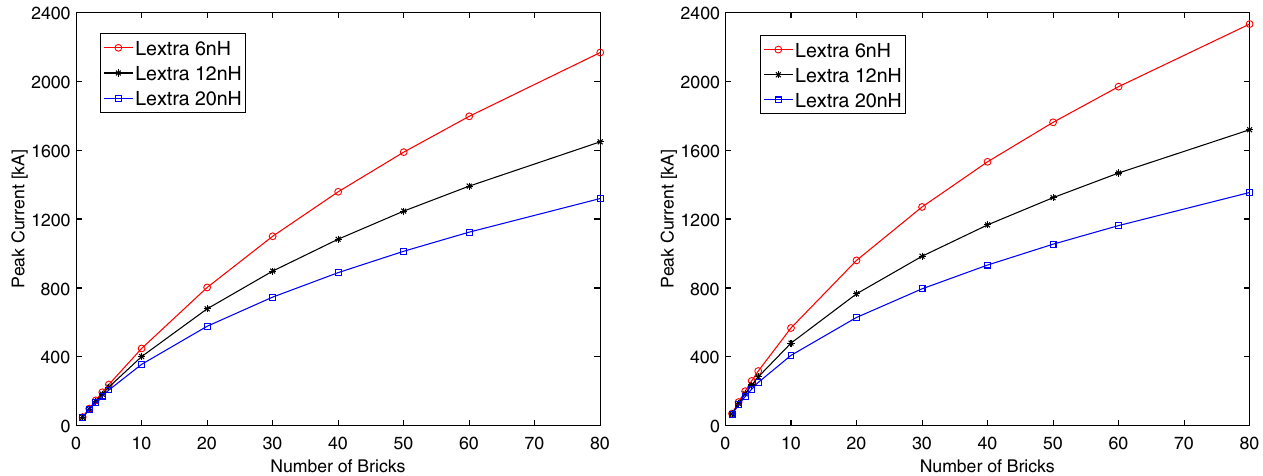
FIG. 6. Scaling of I with N for the standard brick configuration (left) and the dry brick configuration (right) and for cases with peak L ¼ 6 , 12, and 20 nH. The load is always extra